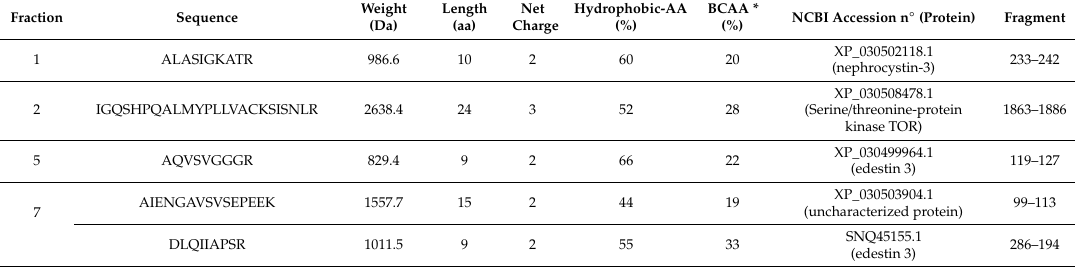
Table 2. List of the peptides identified in the partially purified peptide fraction obtained from the fermented hemp through RP-FPLC. Fermentation was carried out by Lactiplantibacillus plantarum 18S9 and Leuconostoc mesenteroides 12MM1 (ratio 1:1, final cell density of circa 10 7 cfu / g) at 30 ◦ C for 24